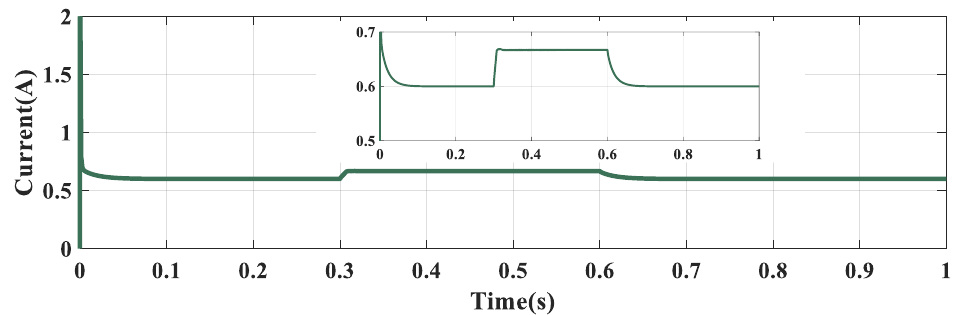
Figure 25. Study 4: load